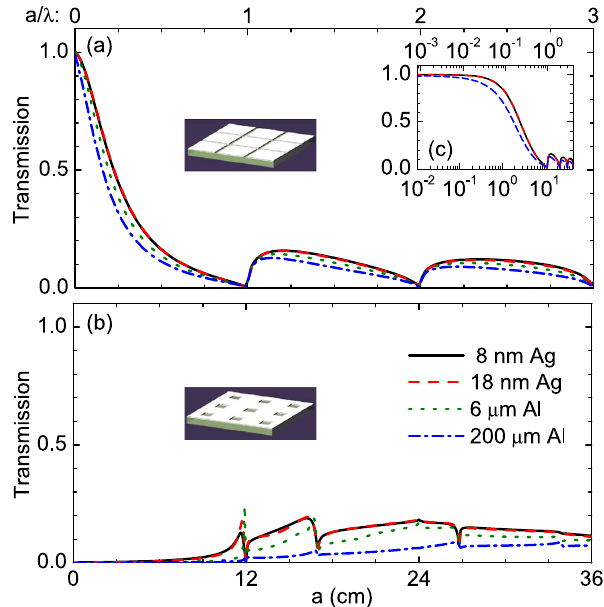
Figure 4. Transmission properties of low-e metasurfaces at 2.5 GHz. ( a , b ) Calculated transmission of the structure in Fig. 3(b,c) with different periodicity at frequency of 2.5 GHz, respectively. ( c ) Replotting of ( a ) with the periodicity a in a logarithmic